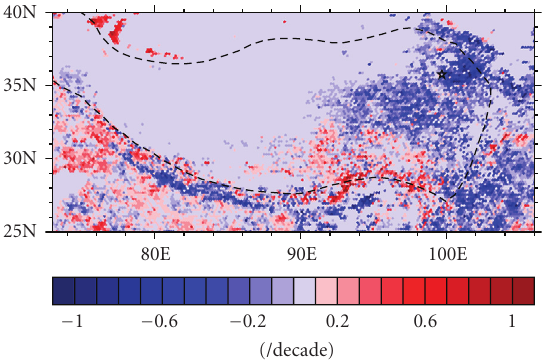
Figure 1: The LAI trend in the TP over the period of 1983–2000 (unit: /decade). The dashed line represents the scope of the TP. The black star is the location of the Xinghai station where the SCAM simulations were performed.